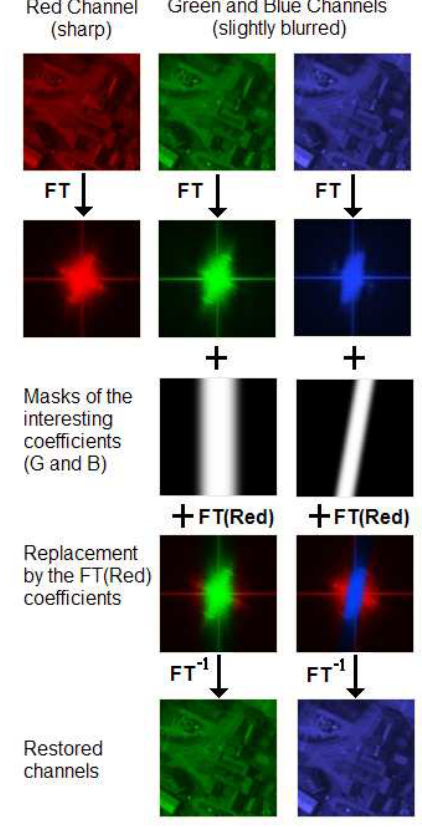
Figure 3. Pansharpening approach used in the case of small motion blur (when the red channel remains sharp)